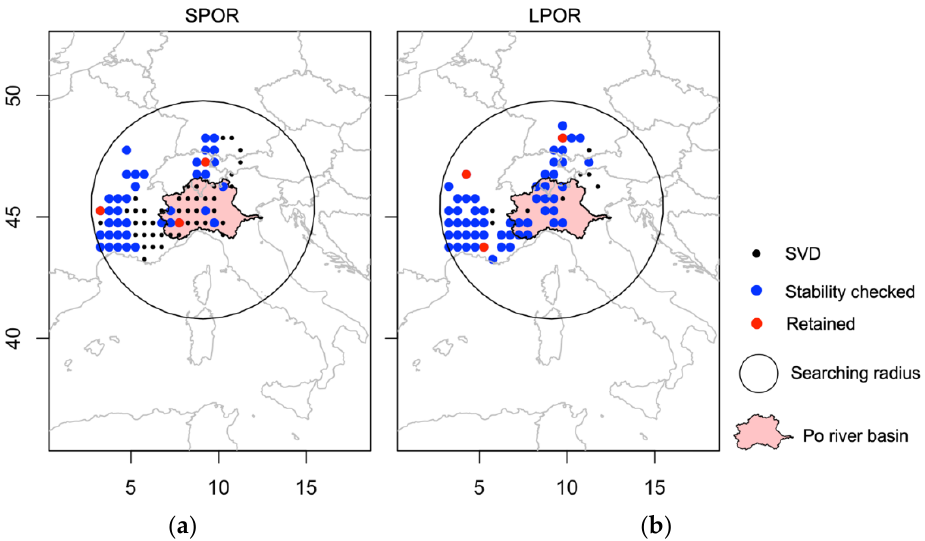
Figure 3. Red circles represent scPDSI cells retained in the SLR model, blue circles represent scPDSI- stable cells that were not retained in the SLR model, and black circles represent SVD-identified cells that were not stable for ( a ) the SPOR reconstruction or ( b ) the LPOR reconstruction.